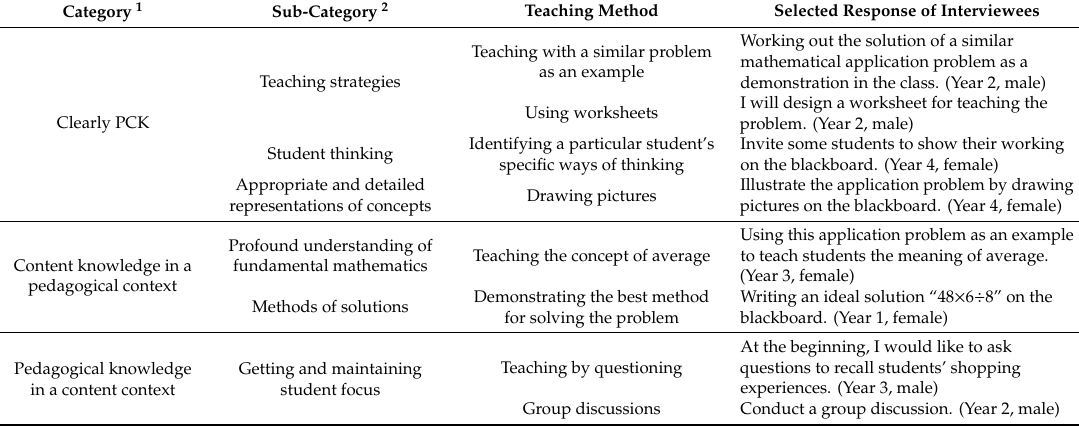
Table 4. Examples for interviewees’ MPCK in teaching a word problem for a class of sixth